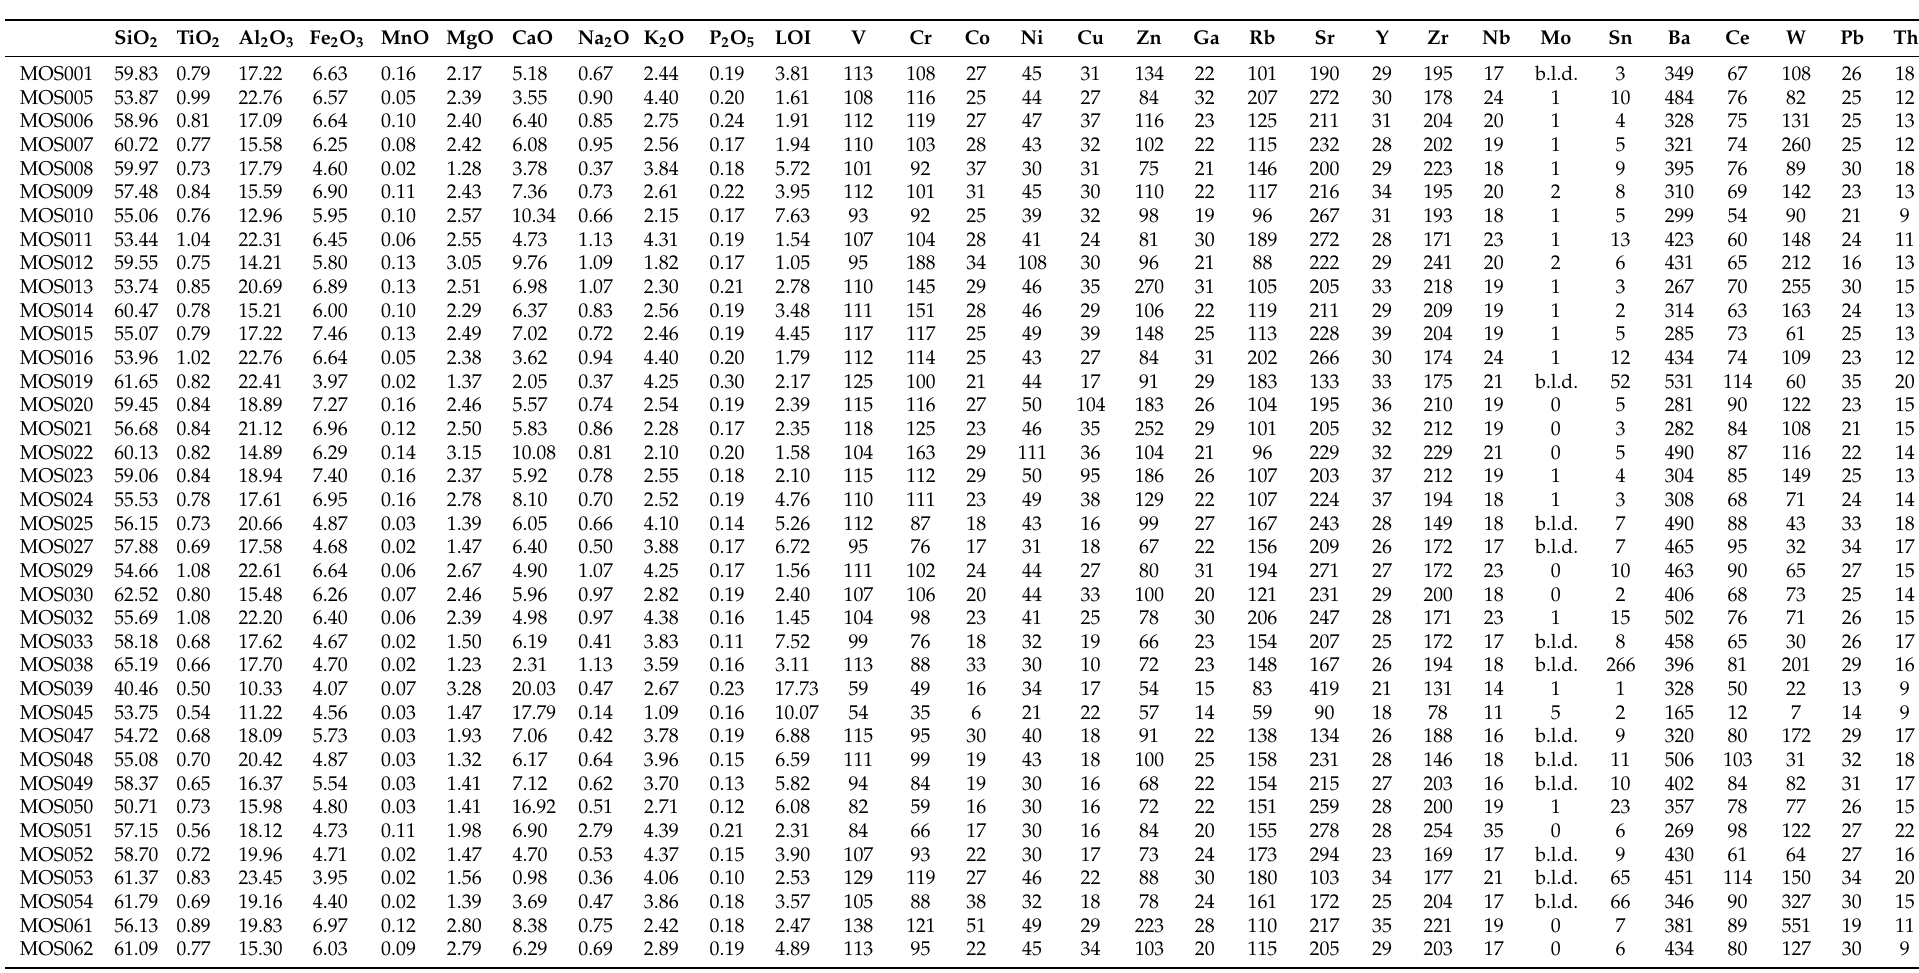
Table 2. Chemical concentrations by WD-XRF. Major and minor elements expressed as oxides are in w %. Trace elements in w mg/kg. LOI (loss on ignition) in w %. b.l.d.: below the limit of